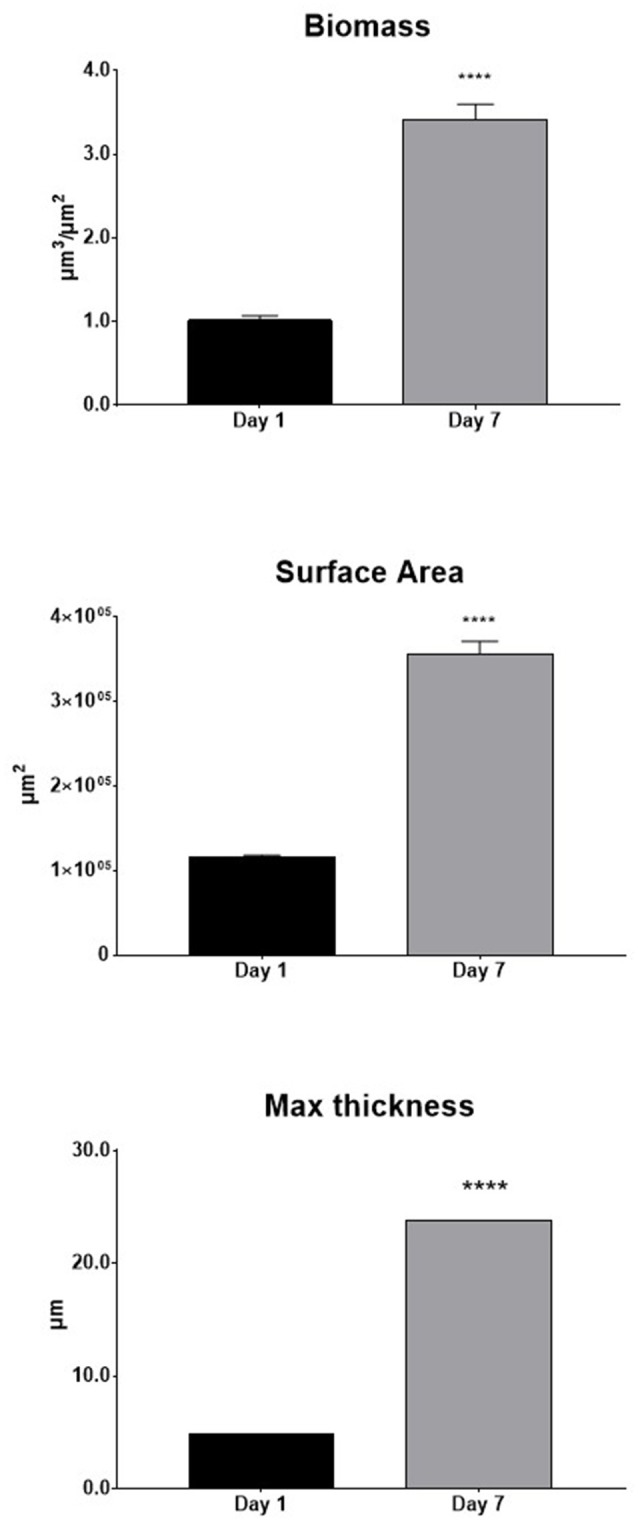
Structural organization of Myroides odoratimimus biofilm analyzed by COMSTAT computer program. Biofilm was allowed to grow in collagen gel matrix in SWF (pH 7.2 and glucose 12.5 mM) for 1 and 7 days, and then image stacks of biofilm were recorded by confocal laser scanning microscopy. Total biomass, surface area, and maximum thickness of biofilm samples were then quantitatively evaluated by COMSTAT software. Results are shown as mean values + SDs. ****p < 0.0001, paired t-test.